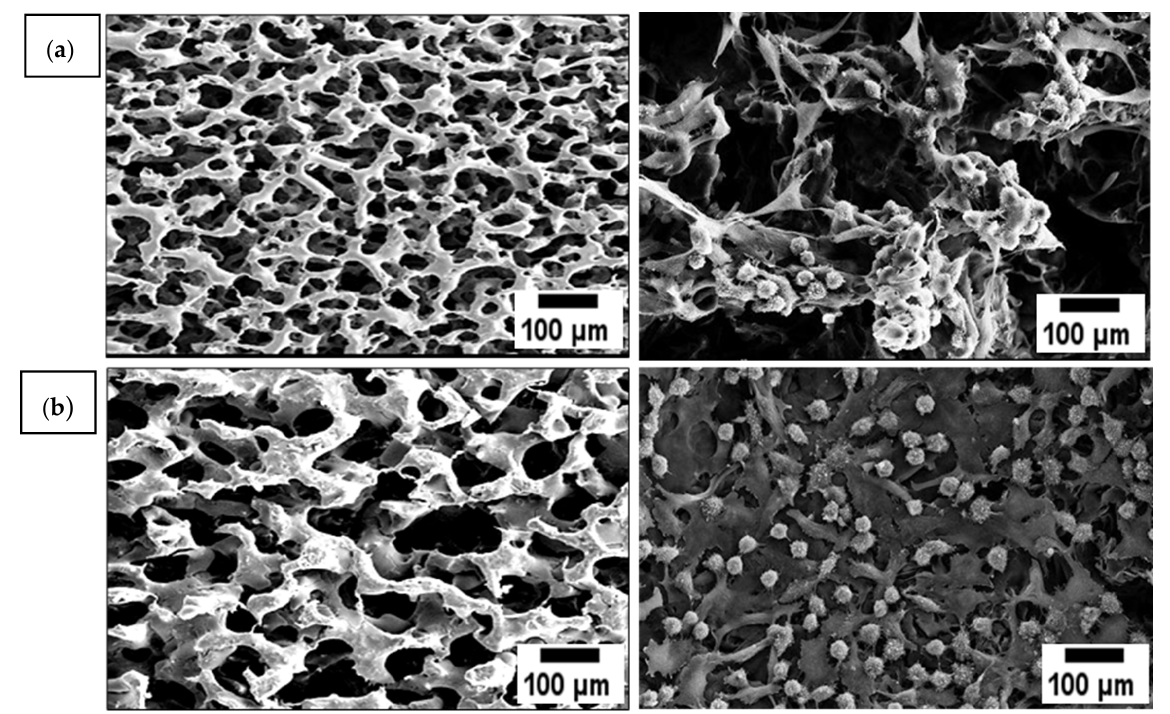
Figure 8. Micrograph of proliferation of L929 cells on ( a ) control-P(3HB- co -4HB), SCCC scaffolds ( b ) SCCC 10 wt.%. Data represent means ± SD ( n = 5).